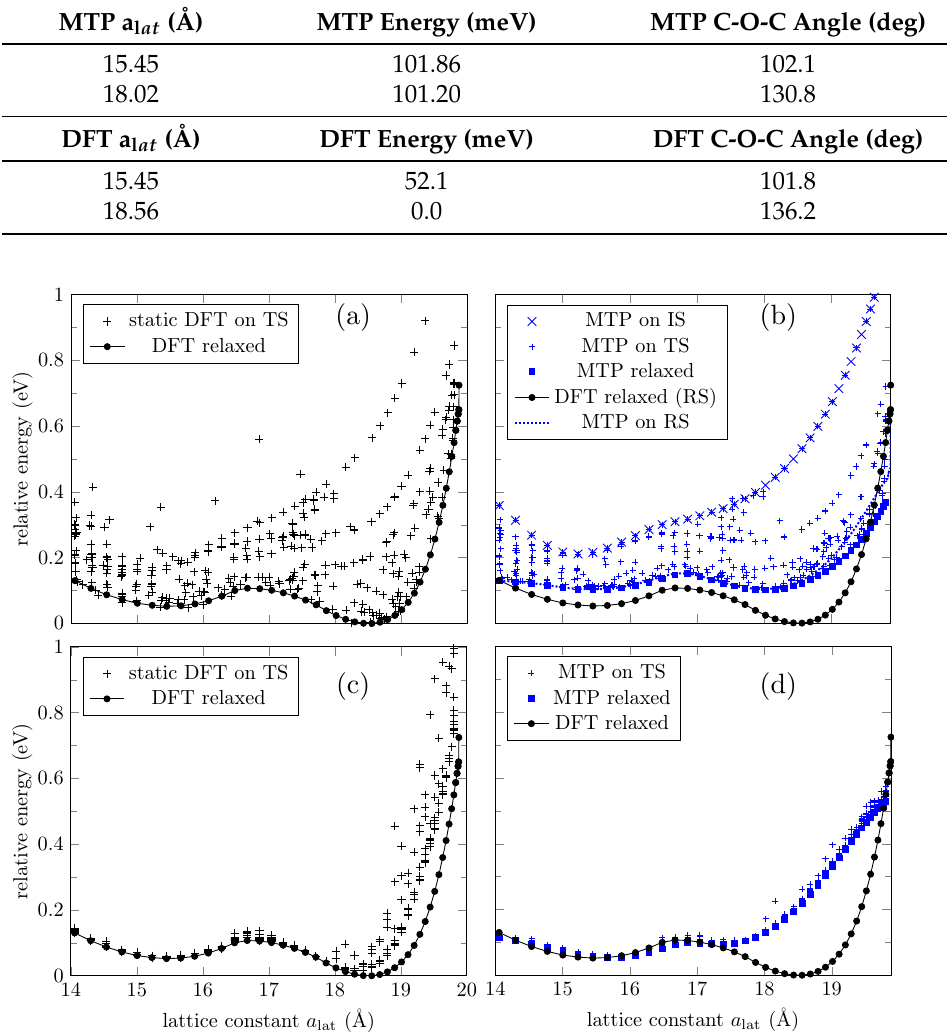
Figure 3. Energy of a GO layer via DFT and MTP. ( a ) Energy distribution of the training set (TS) compared to the ground state energies according to DFT calculations (circle marks). ( b ) Energy distribution of the input set (IS) and TS according to the ML potential. The IS has been relaxed using the ML potential (blue circle marks) and DFT (black circle marks). ( c ) Same as ( a ), but with an improved IS. ( d ) Energy distribution of the TS according to an improved ML potential.